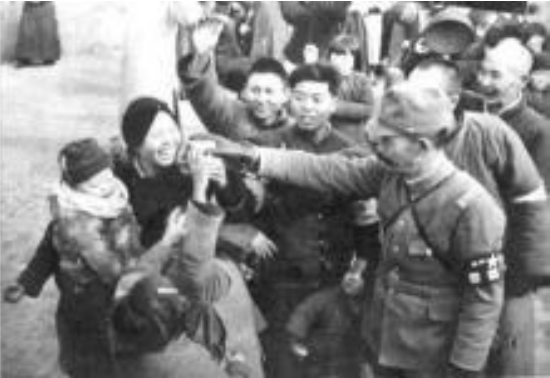
Figure 13. Japanese soldiers handing out sweets to Chi- nese children. Source: The Japan